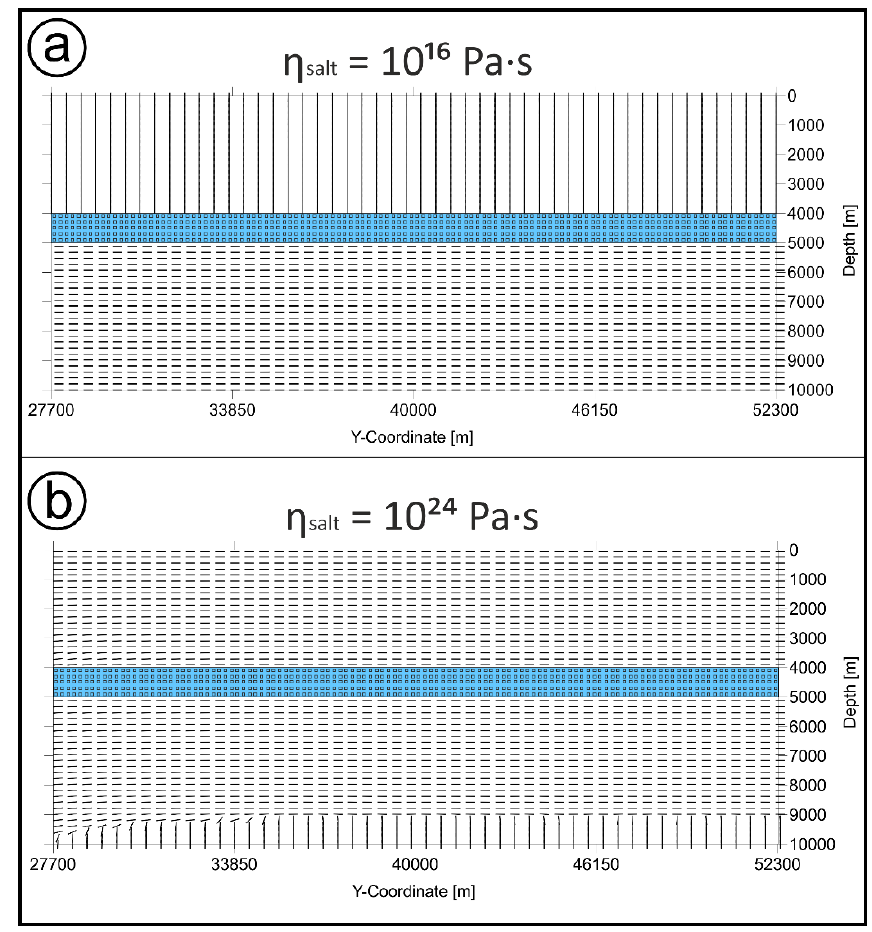
Figure 3. Orientation of the maximum stress (S 1 ) along a vertical section through the centre of a model with a flat salt layer (in blue; see P in Figure 2c) for two different dynamic salt viscosities. Shortening amounts to 400 m and is applied to the subsalt section on the left. ( a ) For a salt viscosity of 10 16 Pa·s (Model A-01), S 1 is vertical in the suprasalt and horizontal in the subsalt region. This also implies a change in the tectonic regime—a normal faulting regime in the upper part and a strike-slip regime in the lower part of the model domain. ( b ) For a salt viscosity of 10 24 Pa·s (Model A-03), S 1 is horizontal in the supra- and most of the subsalt section in spite of the velocity boundary condition being applied to the subsalt part of the model only. Hence, the tectonic regime is largely uniform throughout the model.